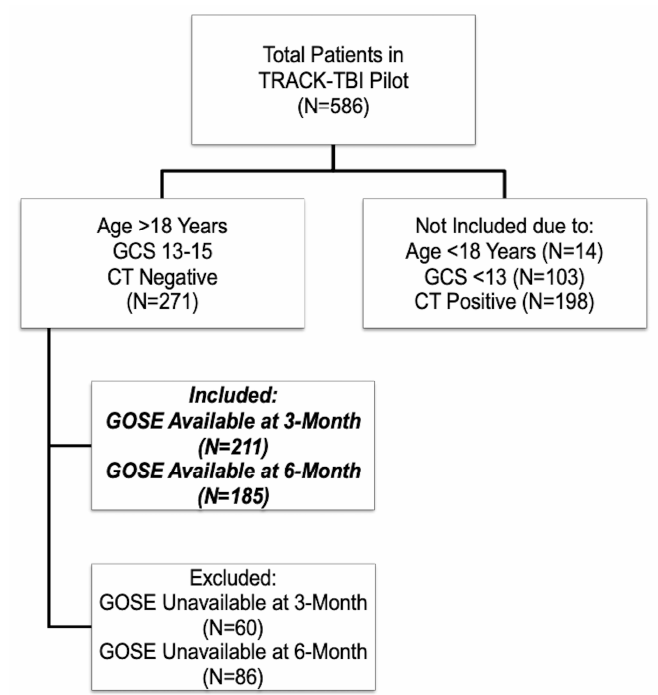
Figure 1. Flowchart of includedsSubjects.